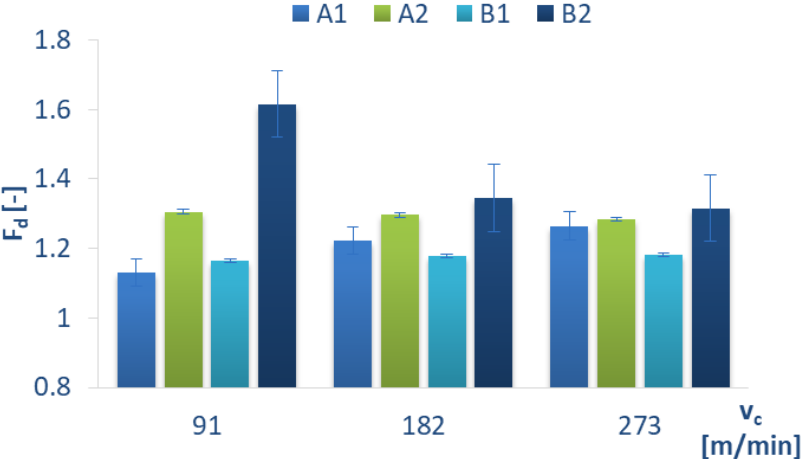
Figure 19. Delamination factor versus different cutting speeds v c and constant feed per tooth f z = 0.016 mm/tooth for different GFRP materials.